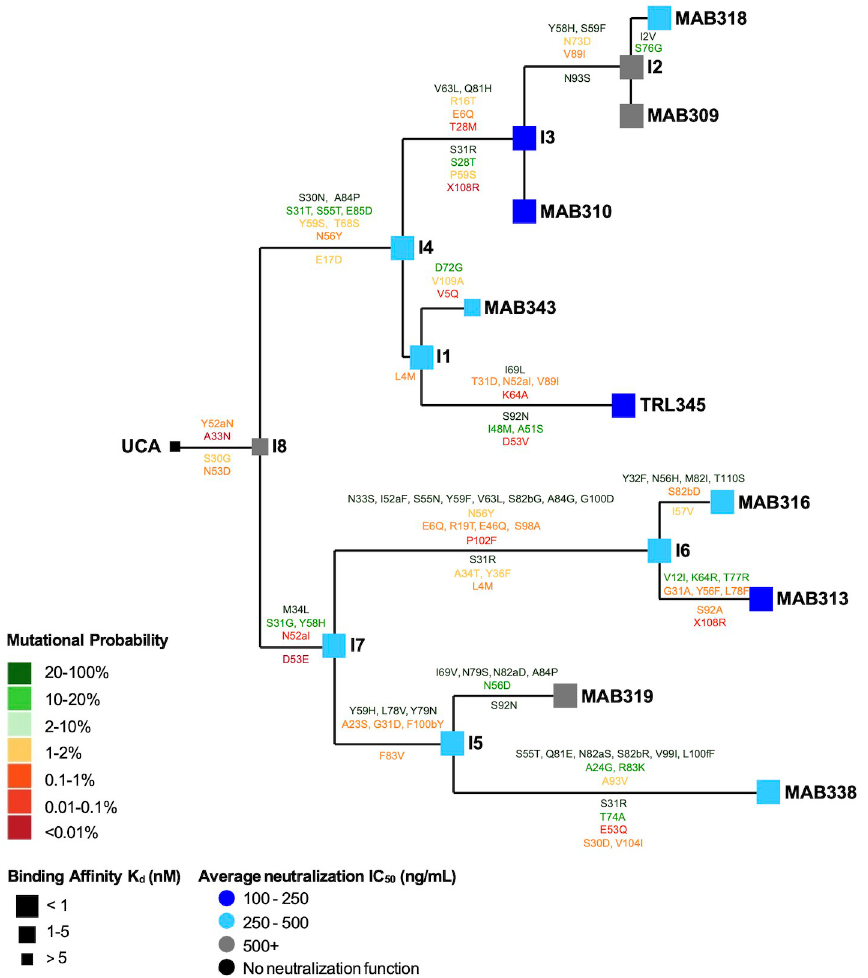
Fig 1. mAb binding to gB ectodomain and CMV neutralization improved along TRL345 lineage maturation. We identified 9 clonally related mature mAbs for phylogenetic relatedness, with the phylogenetic tree showing the relatedness using Cloanalyst, and produced clonal lineage mAbs. We measured mAb binding affinity by SPR and neutralization of the Towne, AD169rUL131-GFP, and Toledo CMV strains on MRC-5 fibroblasts. We reported the binding affinity to gB ectodomain as the Kd (nM), calculated as the k a /k d , from high binding affinity ( < 1 nM, large box) to moderate (1–5 nM, medium) to low ( > 5 nM, small). CMV neutralization is reported as the average IC 50 across all three CMV strains on fibroblasts. The estimated mutations occurring at each transition along lineage maturation are shown above and below the lines of the lineage tree for the heavy and light chains, respectively, and amino acids are numbered according to the Kabat scheme. The probability of a given mutation occurring in the absence of B cell selection was calculated using the ARMADiLLO algorithm, which computationally simulates hypermutation. The mutational probabilities are shown from high probability ( > 10%, dark green) to moderate (2–10%, light green) to low ( < 2%, yellow to red text).